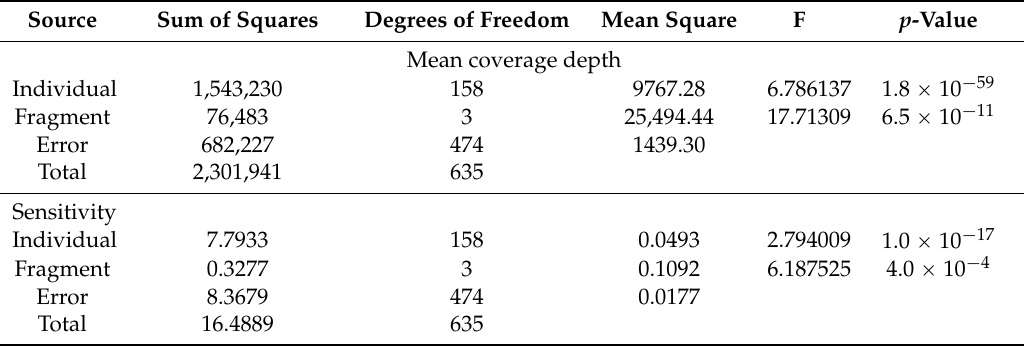
Figure 2. ( a ) Summary of coverage depths of the four fragments (mean ˘ SD); ( b ) Summary of amplicon physical coverage (sensitivity) levels. The effective site was considered when the coverage depth was less than 10-fold; and ( c ) Plot of the relationship between mean coverage depth and sensitivity levels. The regression curve was fit with the Boltzmann function, and the lower boundary of the 95% prediction band of sensitivity is shown. Data were collected from all of the amplicons. Table 1. Two-way analysis of variance on individual and fragment effects on mean coverage depths and sensitivity levels for each amplicon.